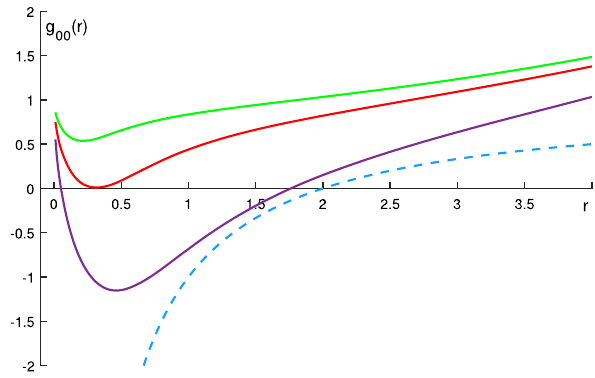
Fig. 4 Plot of g 00 ( r ) versus r for the AdS 4D EGB black hole. AdS 4D EGB pridiction has been depicted from up to down with M < M cri (Green), M = M cri (Red), M > M cri (Purple). Plot has been depicted with α = 0 . 1 and (cid:5) = 0 . 1. Dashed line shows GR